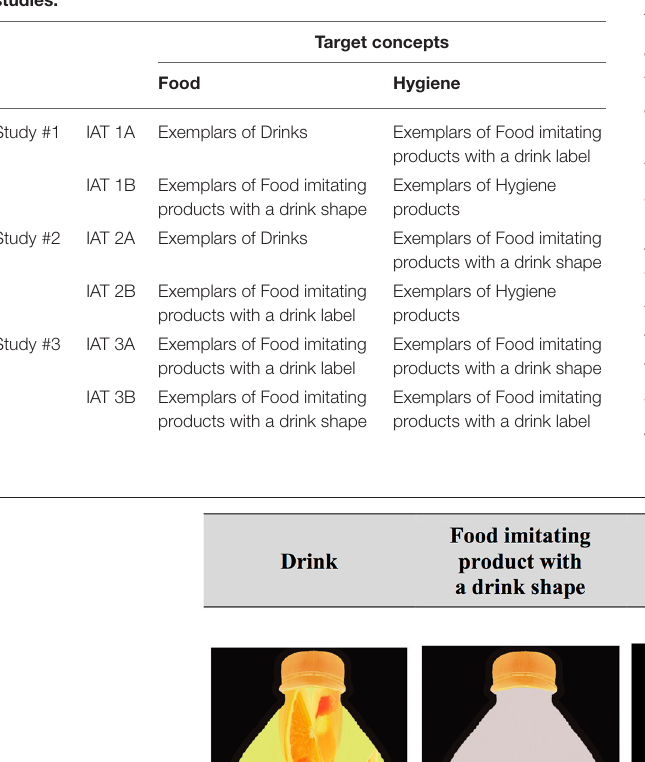
TABLE 1 | Target concepts and their related exemplars across the three studies.